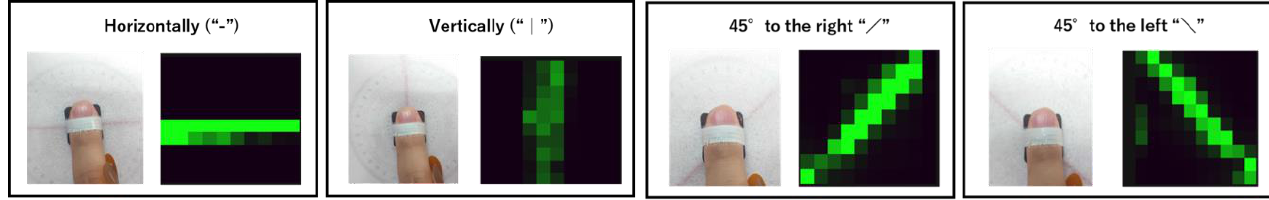
Figure 8. Output of sensor for the straight line at different angles.